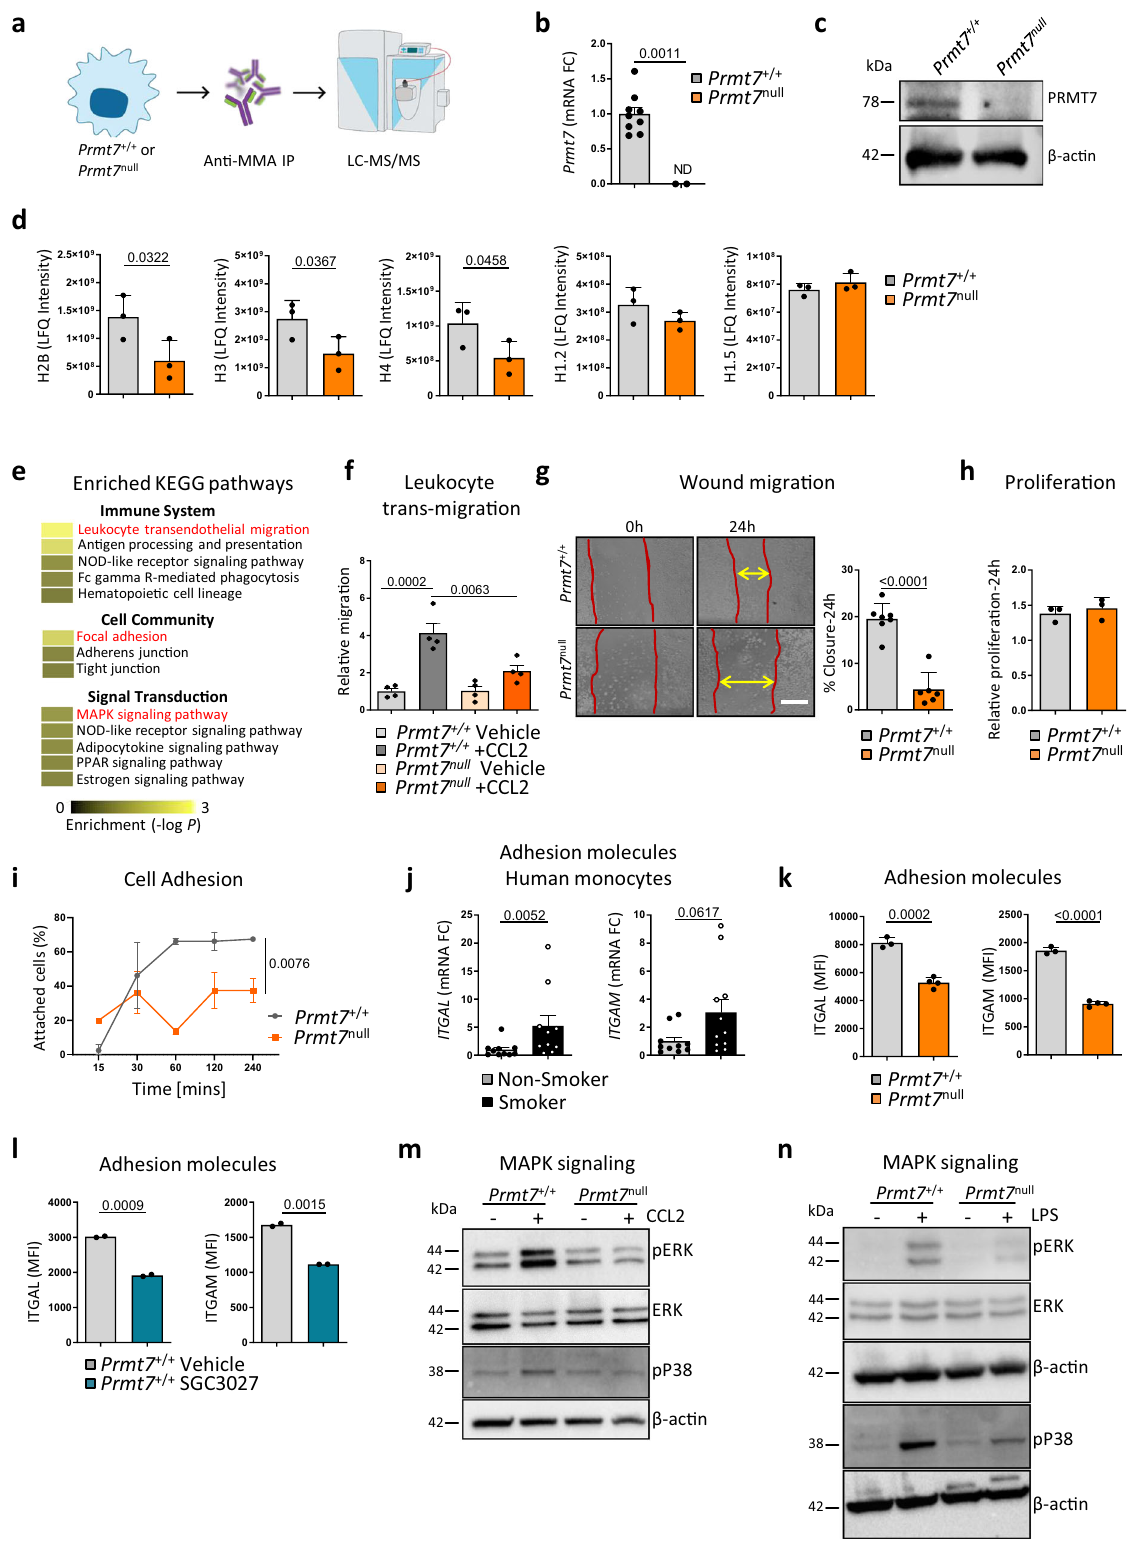
Leukocyte transendothelial migra(cid:2)on An(cid:2)gen processing and presenta(cid:2)on NOD-like receptor signaling pathway Fc gamma R-mediated phagocytosis Hematopoie(cid:2)c cell lineage